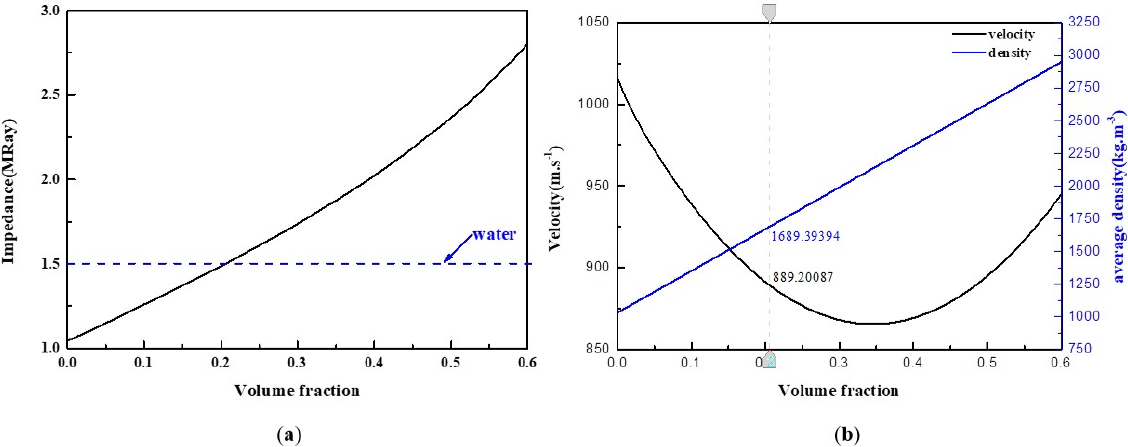
Figure 4. ( a ) The functional relationship between acoustic impedance and volume fraction of com- posite materials. ( b ) Velocity and density of composite PDMS-TiO 2 materials as a function of volume fraction of TiO 2 particles.